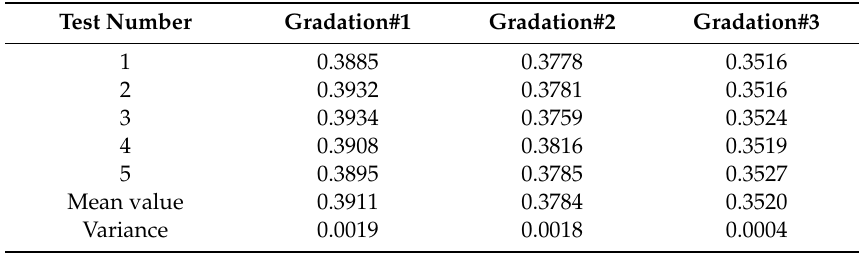
Table 5. Recorded porosity of parallel